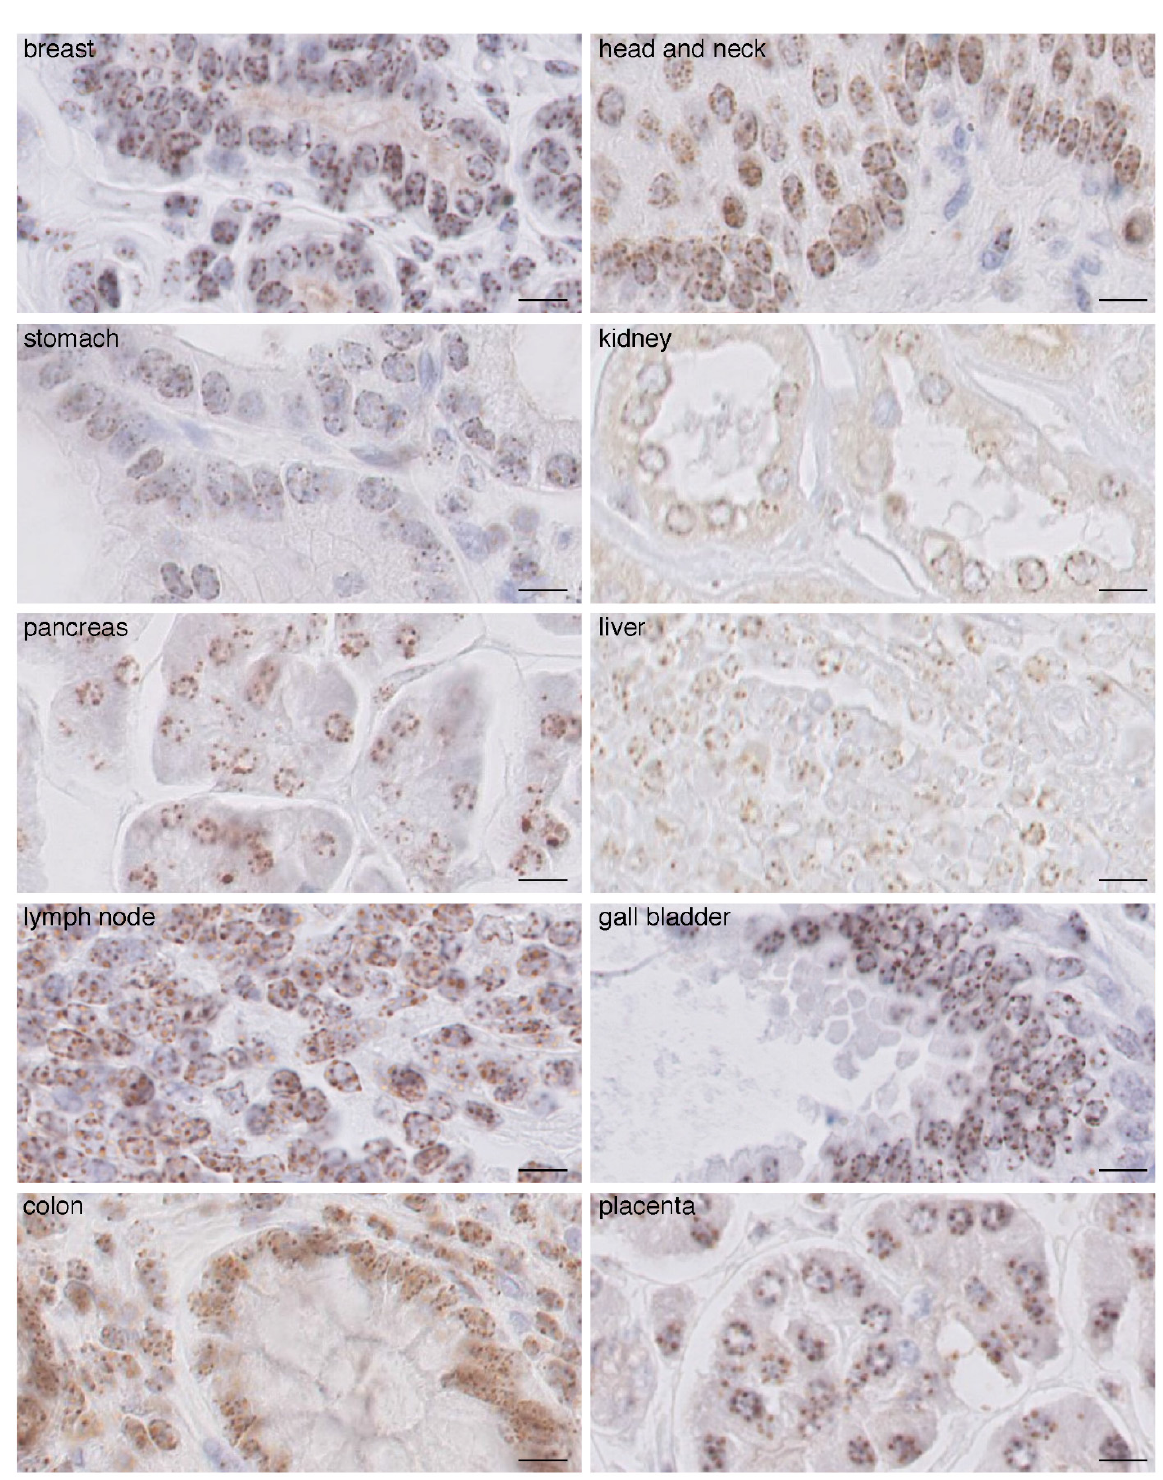
Figure 1. CENP-A staining by IHC in normal human tissues. Images of CENP-A staining by IHC in the indicated human tissues. Scale bar is 10 µm.